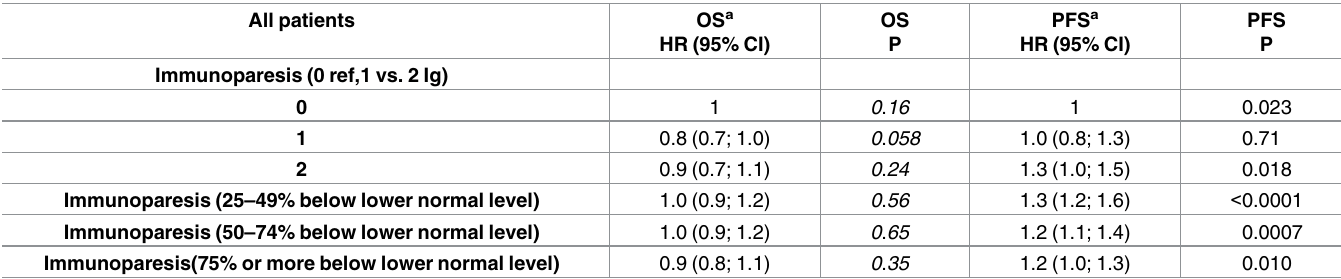
Table 4. Multivariable analysis of both qualitative and quantitative immunoparesis as risk factors for OS and PFS in all patients.